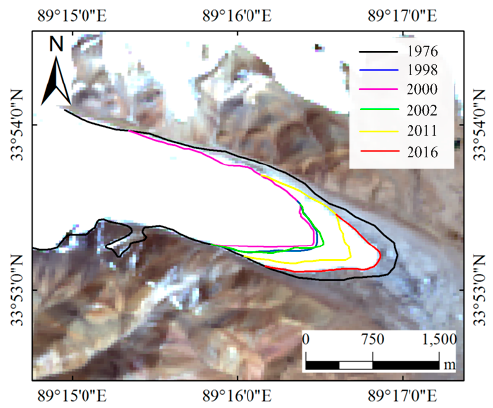
Figure 11. Outlines of glacier 5Z213E0012 in 1976, 1998, 2000, 2002, 2011, and 2016. The background is the Landsat ‐ 8 OLI image acquired in 2016.